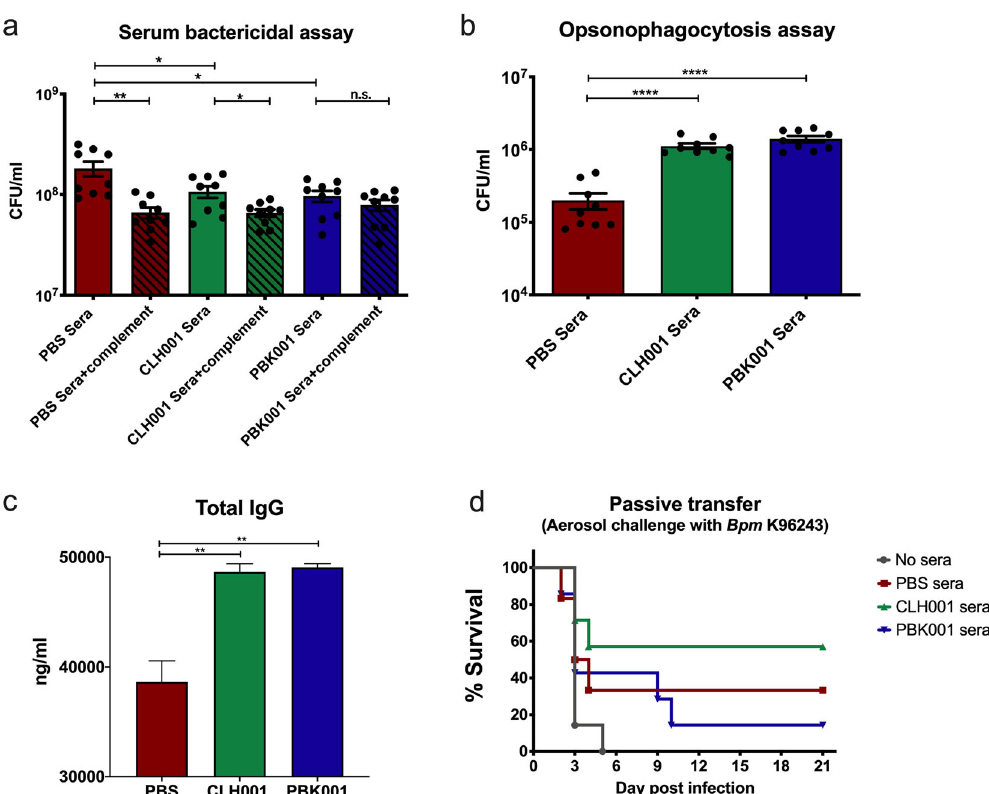
Fig. 2 Serum from CLH001 and PBK001 immunized mice enhances bacterial killing and promotes opsonic macrophage activity but is insuf fi cient to protect mice from Bpm infection. The immune serum from mice ( n = 10) receiving PBS, CLH001, and PBK001 were collected two weeks after the 2 nd boost. a The serum bacterial killing assay was performed by incubating Bpm K96243 cells (1 × 10 6 CFU) with 20% heat- inactivated (HI) pooled serum from non-vaccinated and vaccinated mice with and without complement. CFU/ml was determined after 4 h of incubation. b Opsonophagocytosis assay was performed by incubating the HI pooled serum with Bpm K96243 (5 × 10 5 CFU) for 1 h. Opsonized bacteria were added to RAW 264.7 cells monolayers (5 × 10 5 cells/well). Uptake was quantitated at 3 h post infection. Values of serum bacterial killing and opsonophagocytosis assay are represented as mean ± SEM from three individual assays conducted in triplicate. c Total IgG of post- vaccine sera used for passive transfer was quantitated using ELISA. Data are represented as mean ± SEM of triplicate assay. d Passive transfer of immunized and non-immunized mice was evaluated by i.p. injection of pooled serum (500 μ l) to naïve C57BL/6 mice ( n = 6 – 7/group). Two hours after serum transfer, mice were aerosol challenged with 18 – 30 LD 50 of Bpm K96243. Survival of mice from PBS, CLH001, and PBK001 groups were observed for 21 days. * p < 0.05, ** p < 0. 01, *** p < 0.001, **** p < 0.0001, n.s. = not signi fi cant. P values were determined using unpaired t